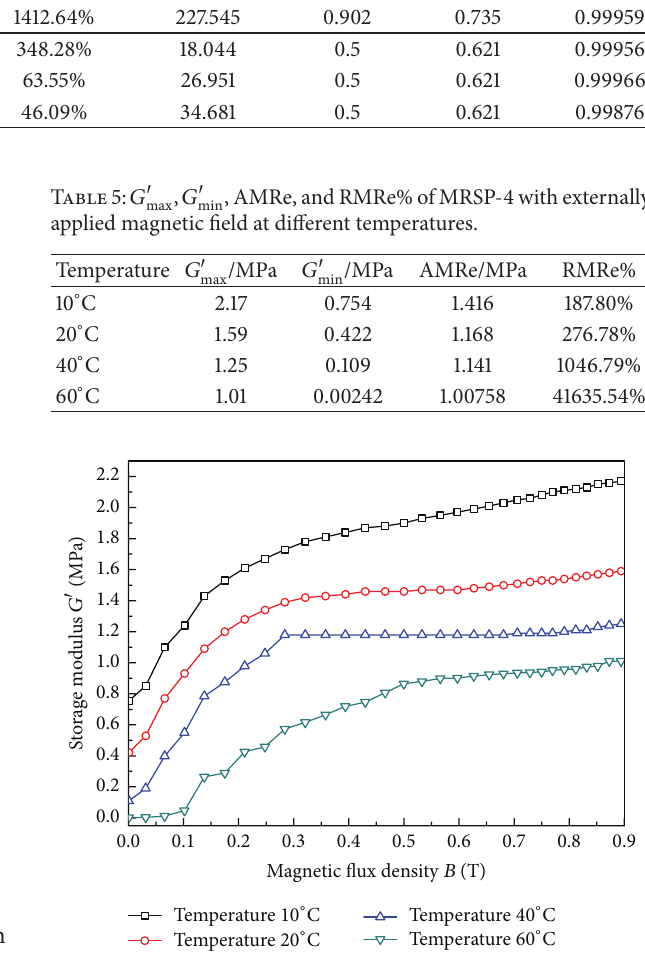
Figure8:Theeffectoftemperatureonmagnetorheologicalproperty for